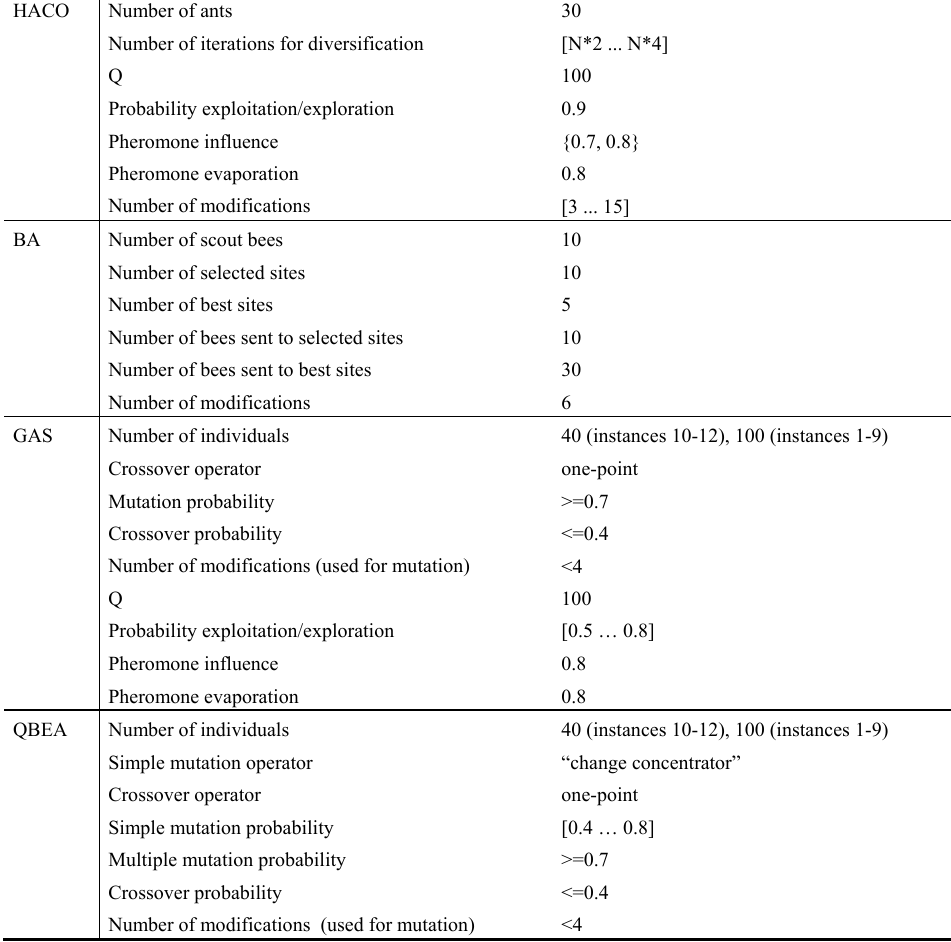
Table 1. Parameter